Question: Briefly state, in one sentence, what is plotted here.
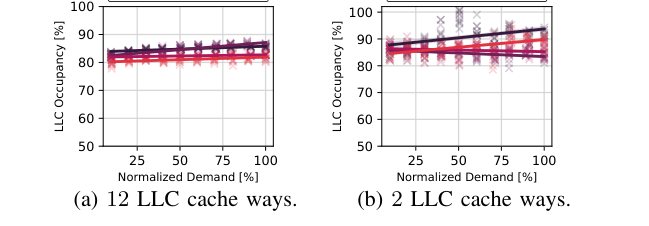
Answer: LLC occupancy in % as a function of the total demand for different SNR cases in UL and DL.